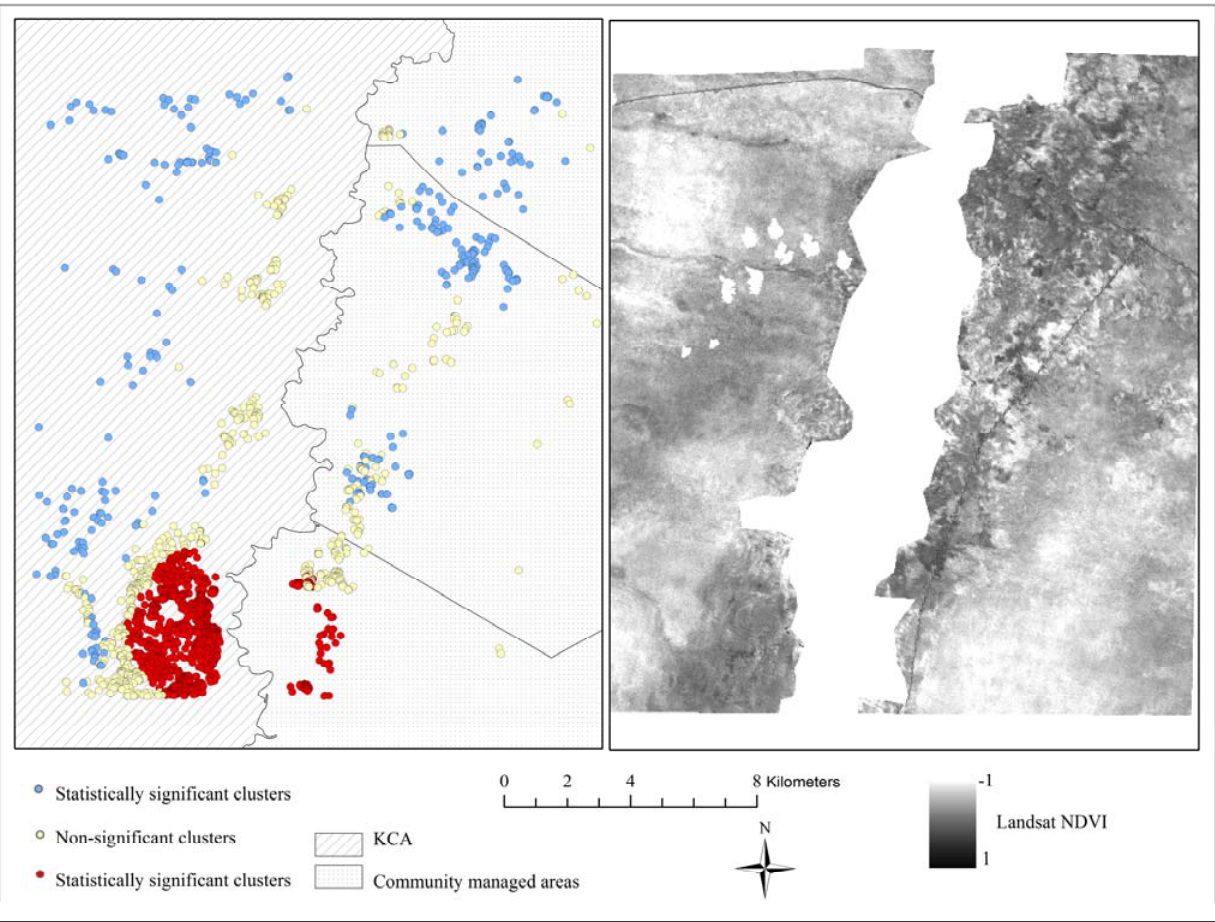
Figure 7. Spatial clustering of trees within the study region for (left) Spatial results of the Getis-Ord Gi * statistic with Bonferroni correction applied to determine statistically significant tree clusters (right) Landsat TM NDVI shown for the same study